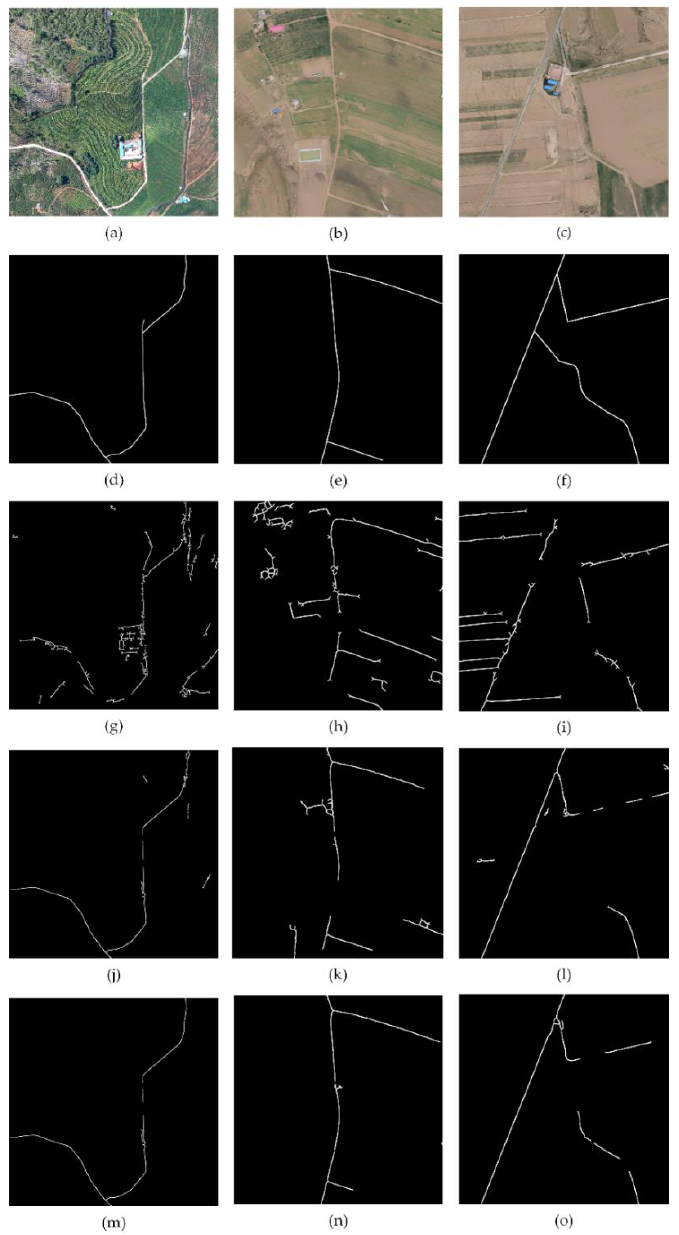
Figure 13. Comparison of the method of Zang et al. [19], Lei et al. [26], and the proposed method in a rural area. ( a – c ) Original image. ( d – f ) Road-vector data from manual acquisition. ( g – i ) Results of the method of Zang et al. ( j – l ) Results of the method of Lei et al. ( m – o ) Results of proposed method. Table 4. Performance of the three road-extraction methods.